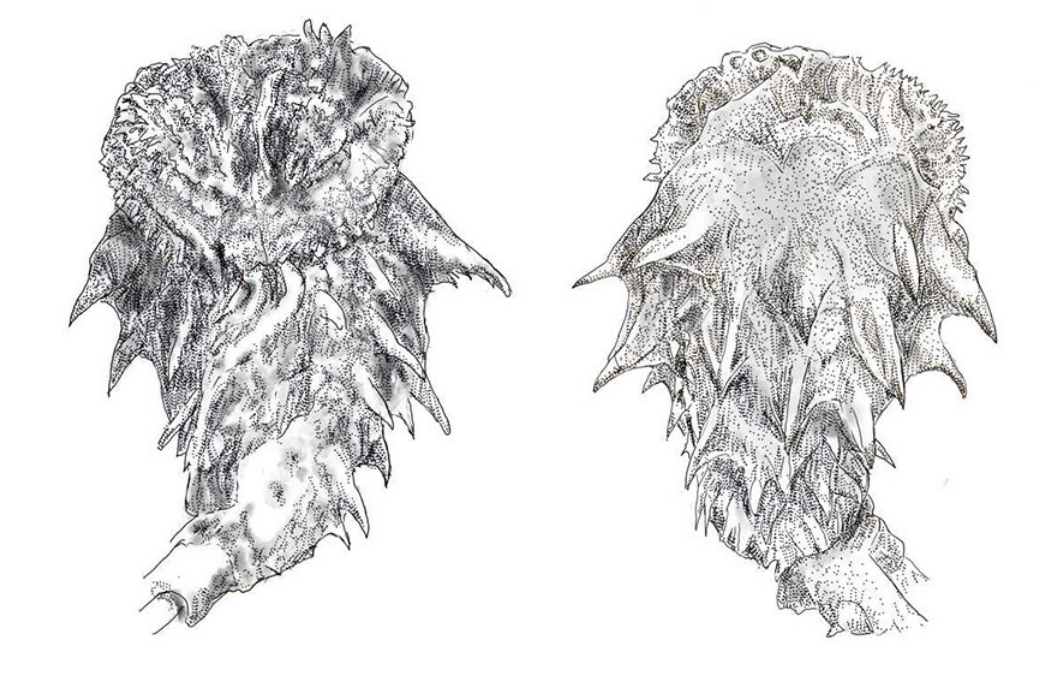
Fig. 5. Apostolepis albicollaris Lema, 2002, hemipenis. Sulcate and asulcate sides. Drawings: Arthur